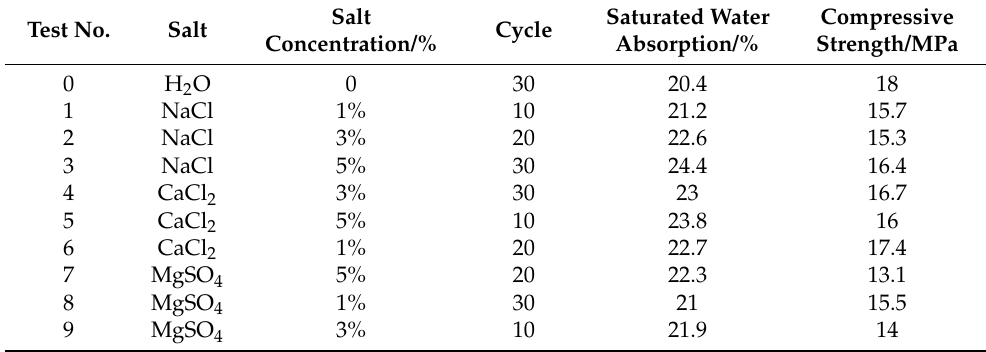
Table 5. Results of orthogonal